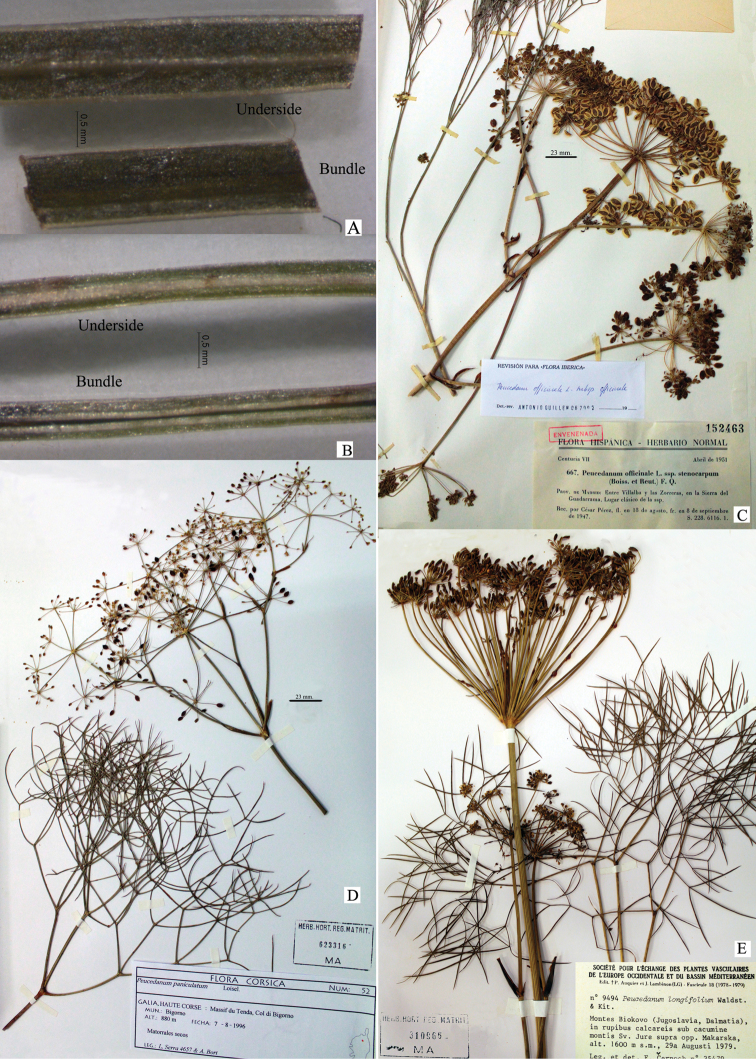
Types of bundle leaf A Flat-bundle leaflet of Peucedanum
officinale
subsp.
officinaleB Canaliculated-bundle leaflet of Peucedanum
officinale
subsp.
album. A comparison of the other subspecies of P.
officinaleCPeucedanum
officinale
subsp.
officinaleDP.
officinale
subsp
paniculatum. EP.
officinale
subsp.
longifolium. Vouchers: C C. Pérez. (MA 152463) D L. Serra & A. Bort, (MA 623316) E, F Cernoch, (MA 310966).